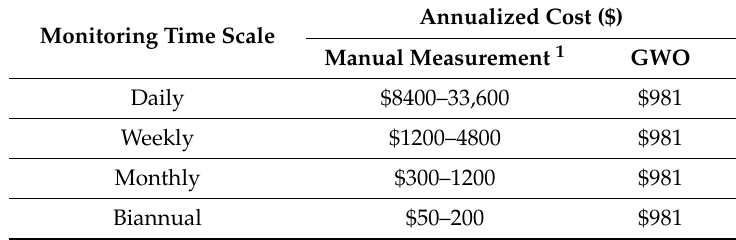
Table 1. Cost comparison of manual measurements and the Groundwater Observatory (GWO).